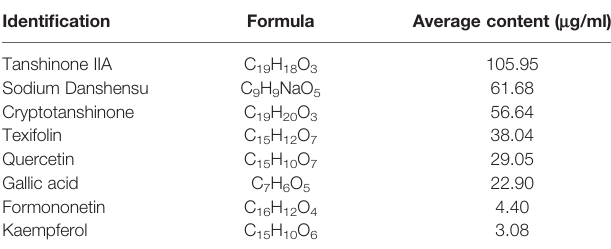
TABLE 1 | Content of dominating compounds.